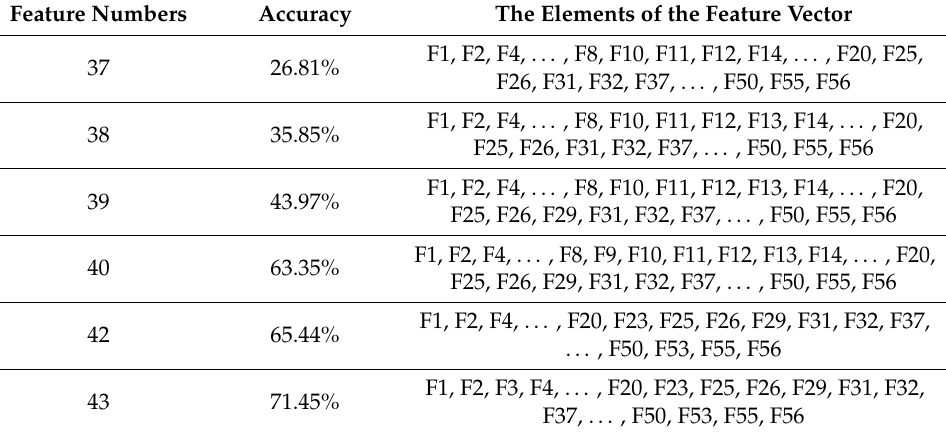
Table 3. Result of ReliefF.